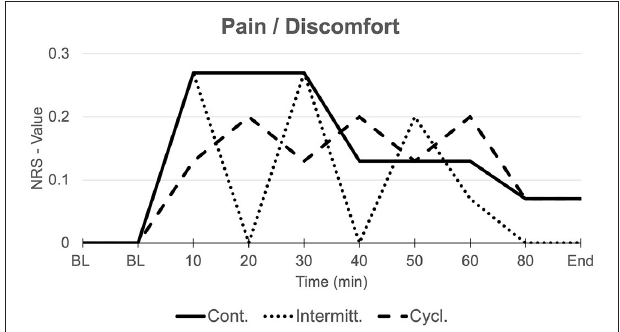
FIGURE 4 | Discomfort/Pain. Mean elicited discomfort, respectively pain (NRS) in all three groups over the course of measurements. Mode of applied suction (continuous, intermittent, cyclic) is mimicked by participants sensation.